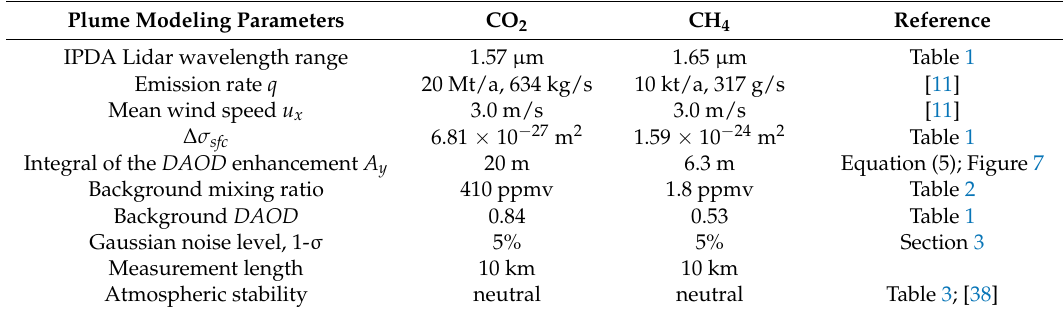
Table 4. Assumed emission rates, typical for large point sources, and auxiliary parameters used for plume